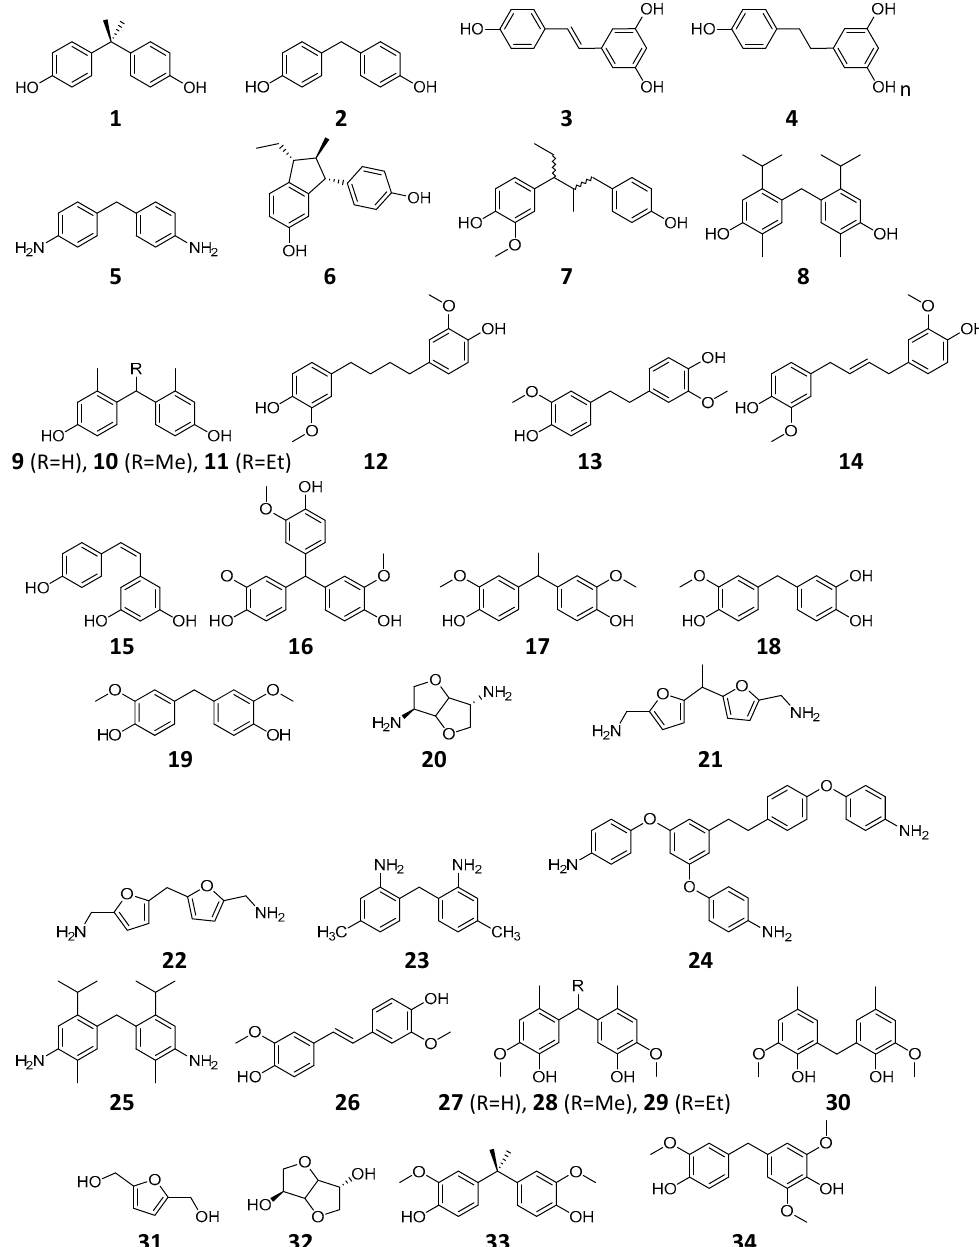
Figure 1. Structures of the 34 potential BPA replacement compounds and the reference compound BPA. The numbers under structures were used in the text and Tables.